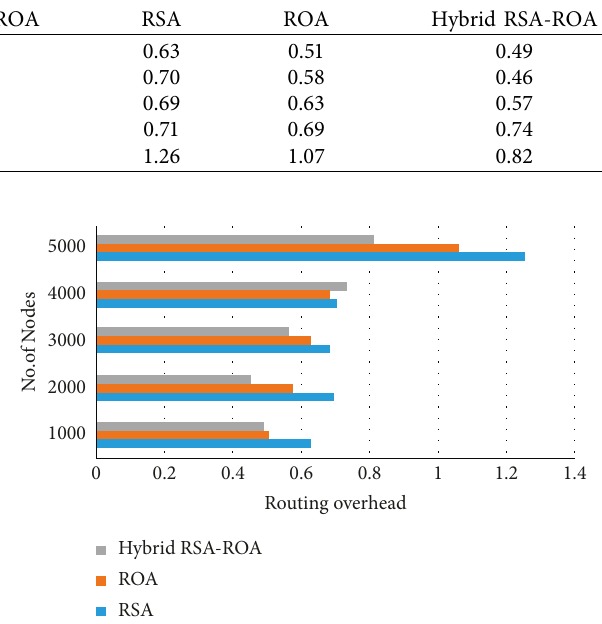
Figure 8: Graphical representation of the proposed method in terms of routing overhead for network